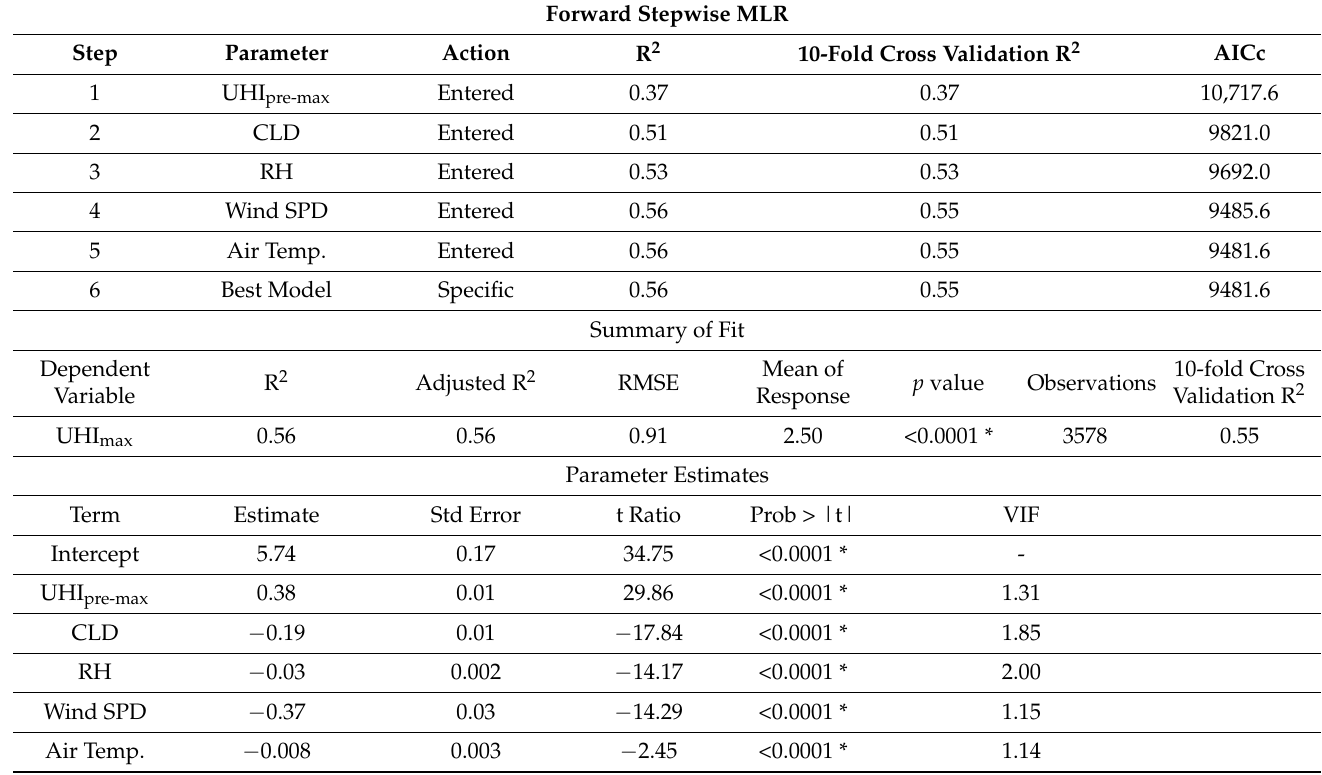
Table 6. Statistical model of UHI max of the whole year using stepwise MLR (2002–2012, incomplete observations were excluded, * statistically